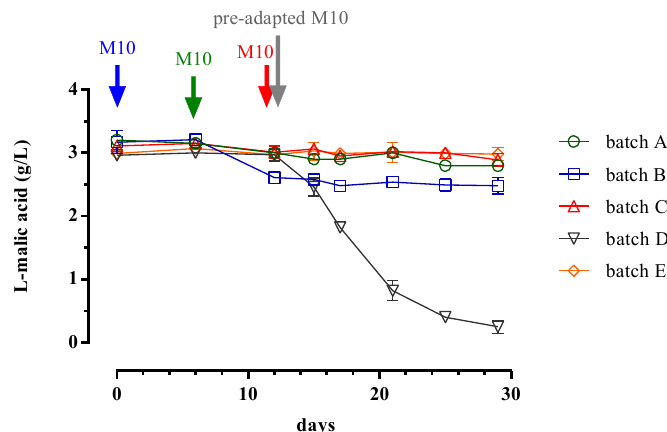
Figure 3. Consumption of L ‐ malic acid during the Fiano winemaking process after the inoculum of Lb. plantarum M10 according to several strategies. Batch A, late co ‐ inoculum strategy; Batch B, early co ‐ inoculum strategy; Batch C, sequential inoculum non ‐ pre ‐ adapted strategy; Batch D, sequential inoculum pre ‐ adapted strategy; Batch E, control. The arrows indicate the time of Lb. plantarum M10 inoculum.